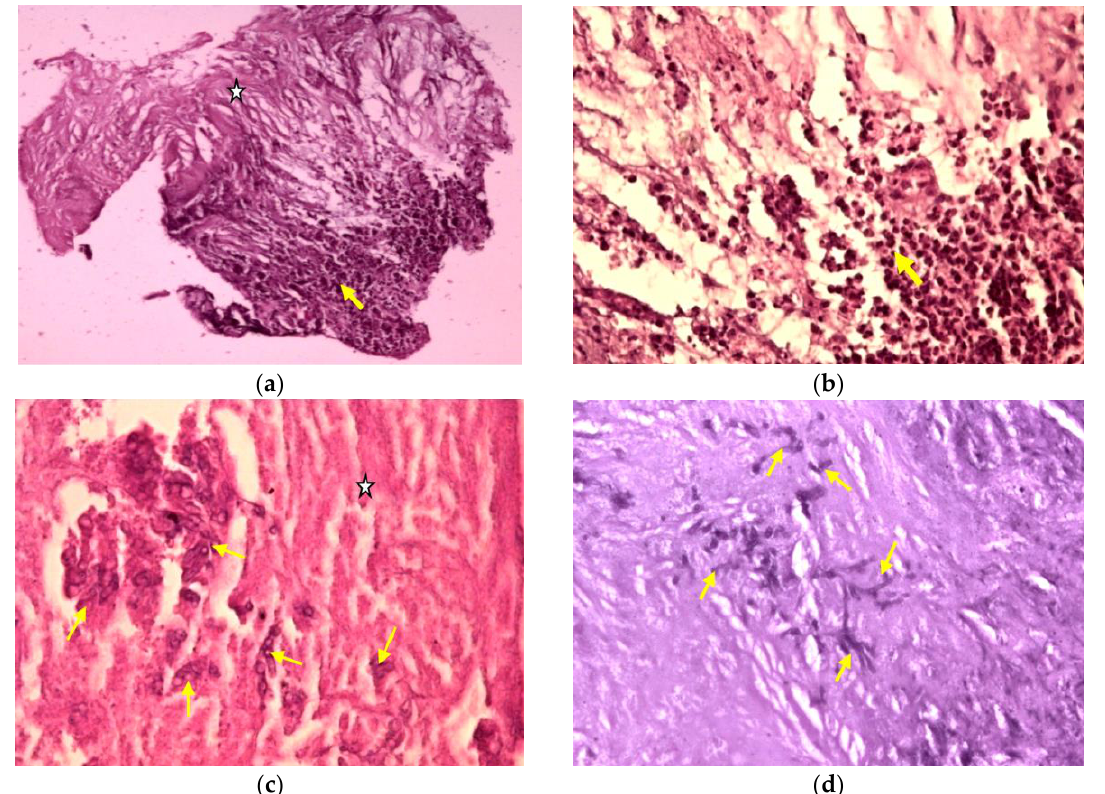
Figure 7. Microphotographs: ( a ) Spinal cord histological architecture was replaced by an extensive area of coagulative necrosis (white star), surrounded by dense acute inflammatory infiltrate (yellow arrow) (HE, ×100). ( b ) The same histological area with a higher magnification showed the necrotic area being surrounded mainly by numerous neutrophils (yellow arrow) (HE, ×400). ( c ) Another specimen showed extensive coagulative necrosis with clusters of hyphae inside (HE, ×400). ( d ) The same histological area, stained with Periodic acid–Schiff (PAS) staining method, showed colonies of dichotomous angle branching hyphae of Aspergillus spp . embedded in the necrotic material (PAS, ×200).